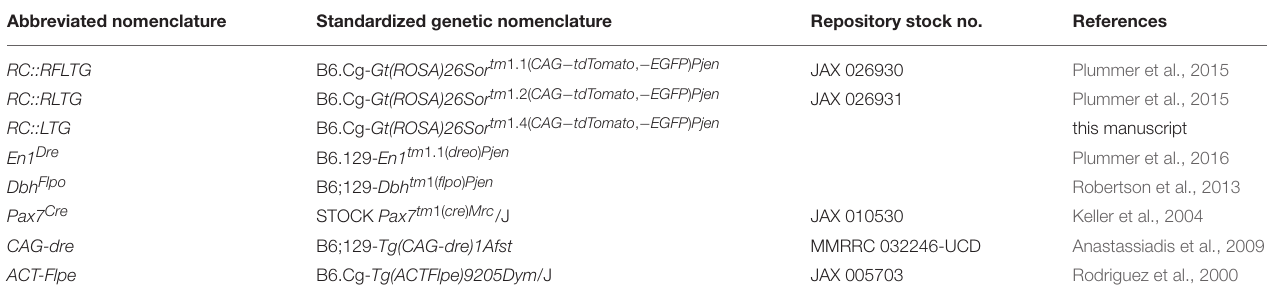
TABLE 1 | Mouse lines used in this